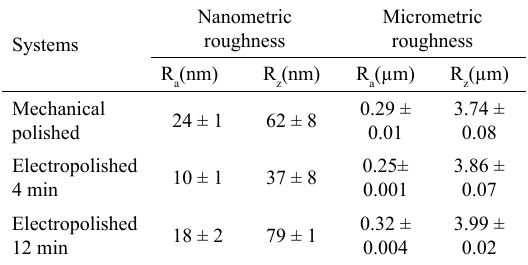
Table 2. Measurements of nanometric and micrometric